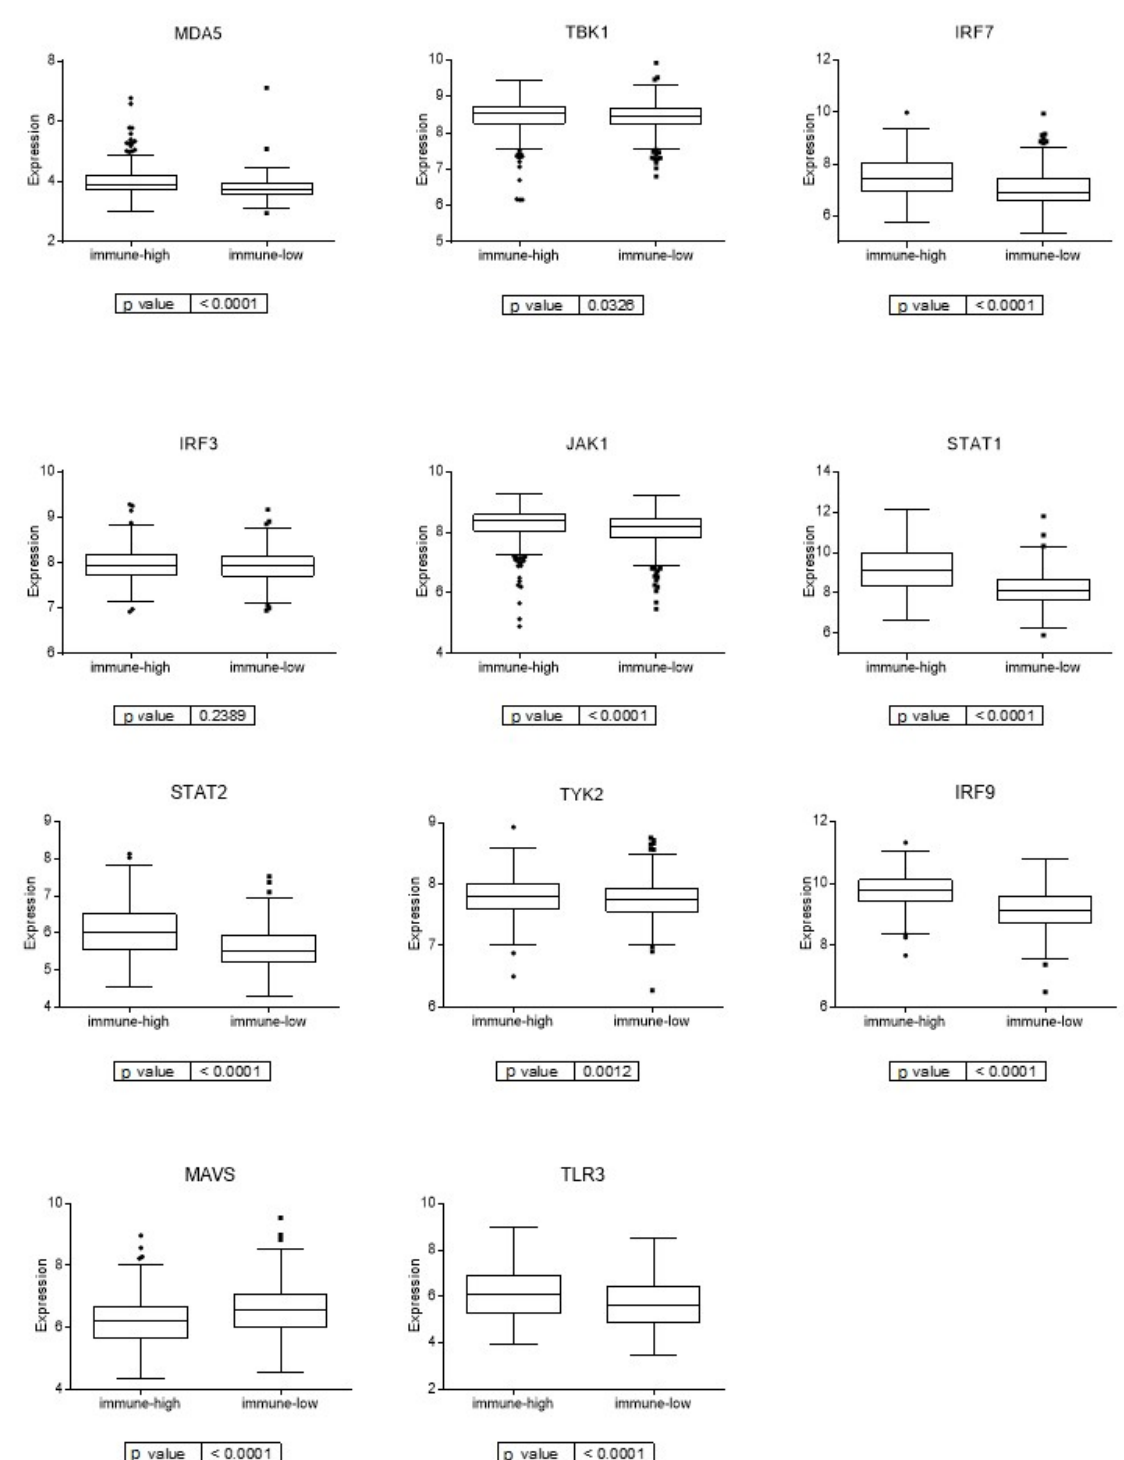
Figure 5. Expression of genes involved in viral mimicry response in the two immune groups.